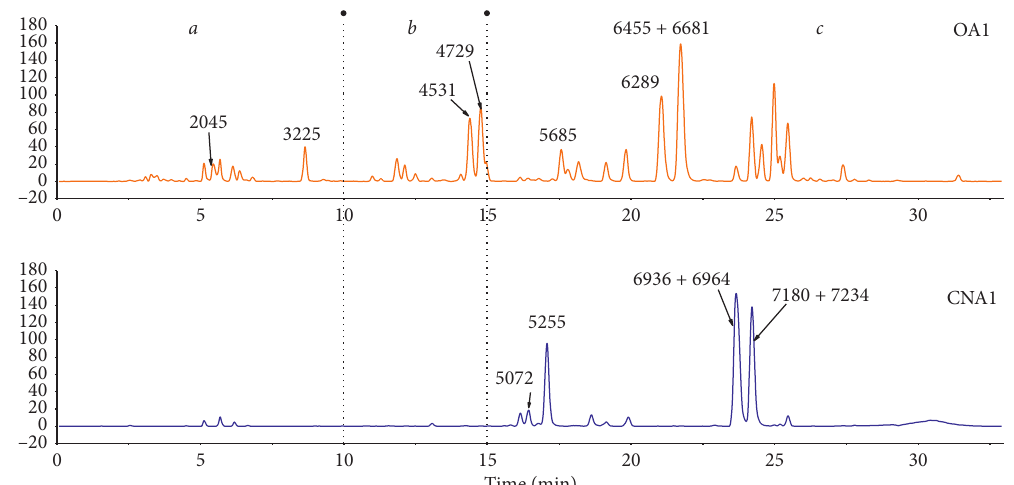
Figure 1: The total ion chromatograms of Chi-Nan agarwood (CNA1) and ordinary agarwood (OA1) acquired by LC-MS. ( a zone: 0–10min; b zone: 10–15min; c zone: 15–30min).